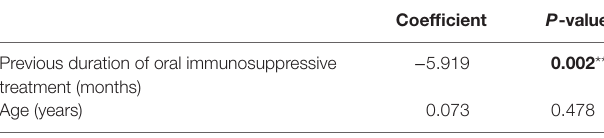
TaBle 4 | Summary of multiple regression model of methylation of FoxP3 Treg-specific demethylated region.